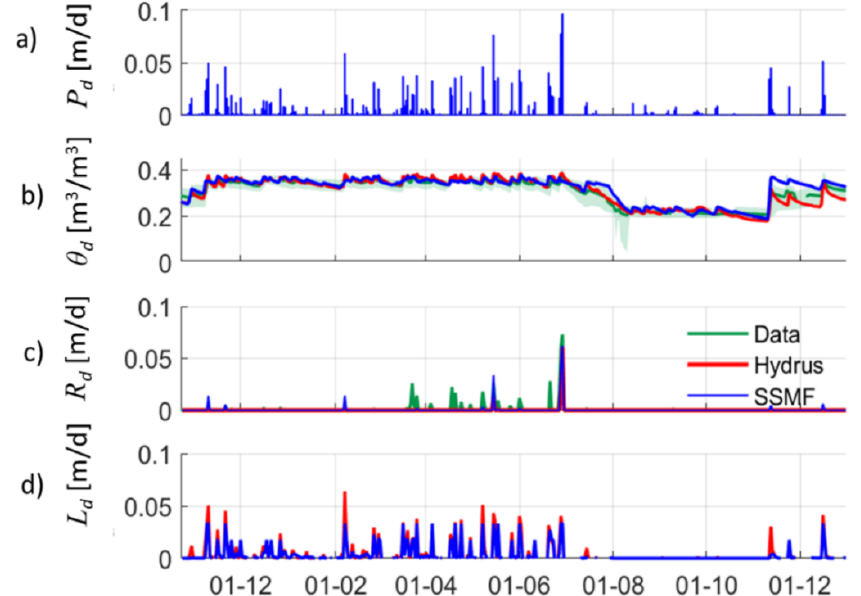
Figure 4. Daily observed precipitation ( a ), soil water content θ d ( b ), overland flow R d ( c ), and vertical flux L d ( d ) in the CZO clay loam profile of the Sunjia catchment at z r = 0.40 m, from November 2012 until December 2013. In ( b – d ), the time series are obtained from the calibrated HYDRUS software (red) and from the Shallow Subsurface Modelling Framework (SSMF, blue). For θ d ( b ) and R d ( c ), the data range and its average value across the 12 sensors are represented respectively by a green shaded area and a green line.